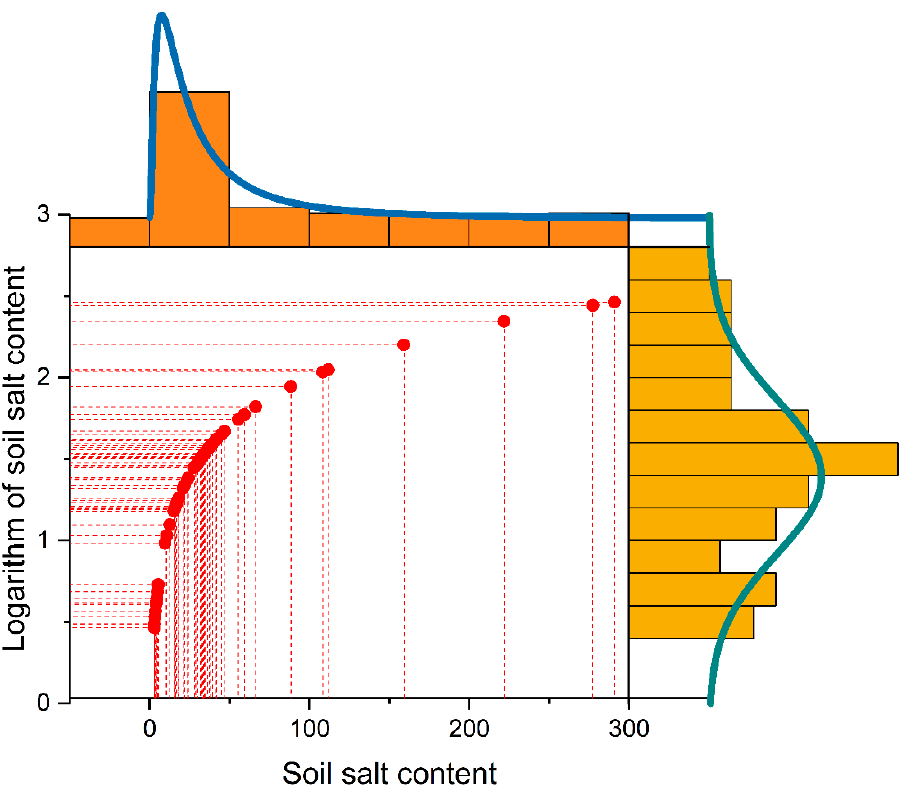
Figure 5. Soil salt content parameter data distribution. The horizontal axis represents soil salt content. The vertical axis represents the logarithm of soil salt content. Each point represents every piece of data. The histogram shows the distribution of the data. It indicates that the soil salt content parameter data is in a normal distribution, after the logarithmic